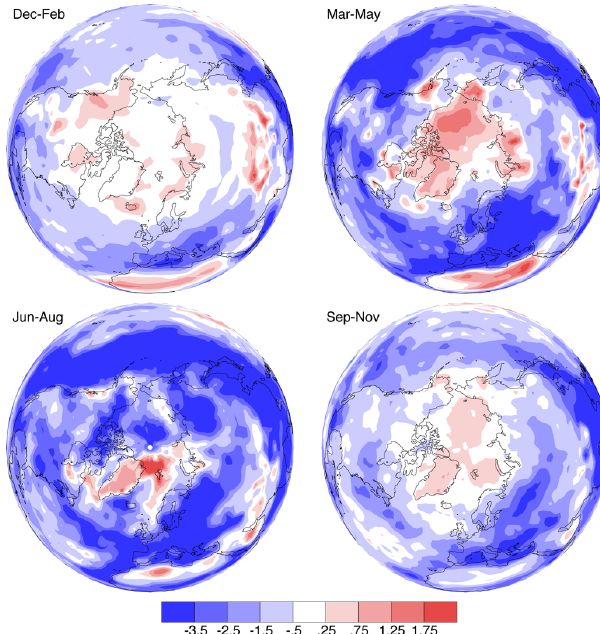
Fig. 16. Multi-model mean Northern Hemisphere aerosol ERF for 2000 relative to 1850 for the indicated seasons.